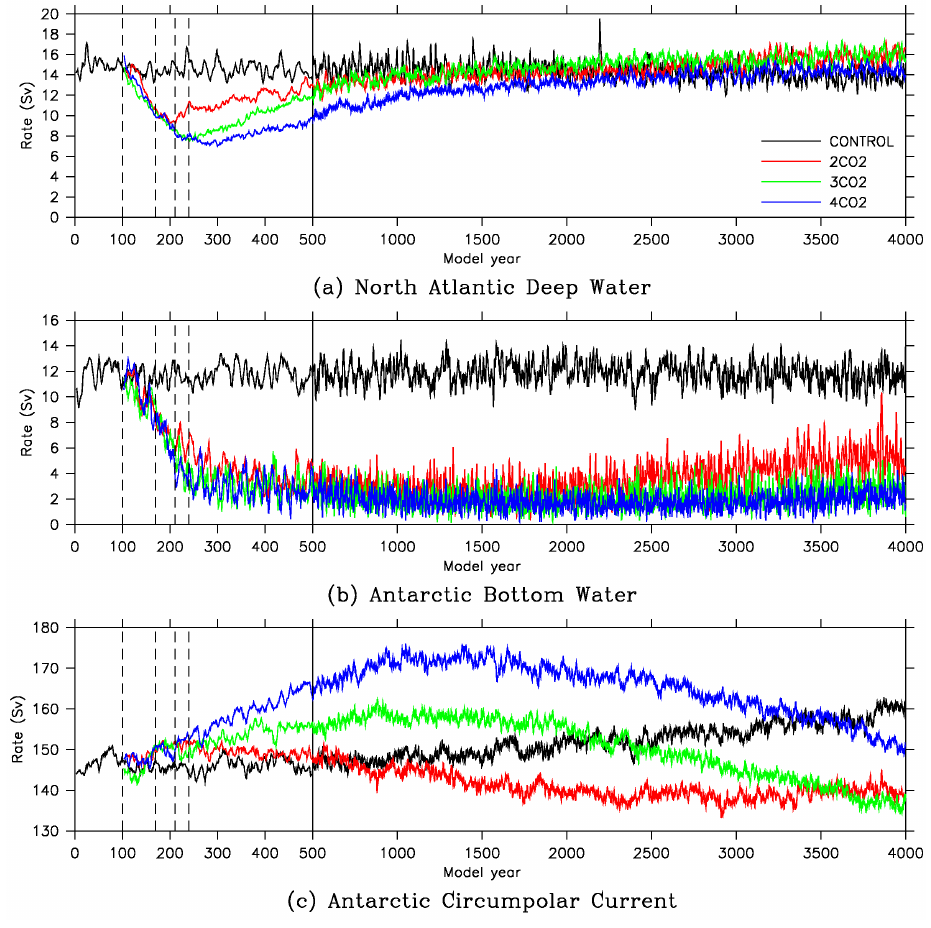
Fig. 23. The changes in the rates of deep water formation and the strength of the Antarctic Circumpolar Current during experiments CON- TROL (black), 2CO2 (red), 3CO2 (green) and 4CO2 (blue): (a) North Atlantic Deep Water, (b) Antarctic Bottom Water, and (c) the Antarctic Circumpolar Current. The values shown are five-year running means and vertical dashed lines indicate model years 100, 170, 211 and 240. Note the change in the scale of the time axis at year